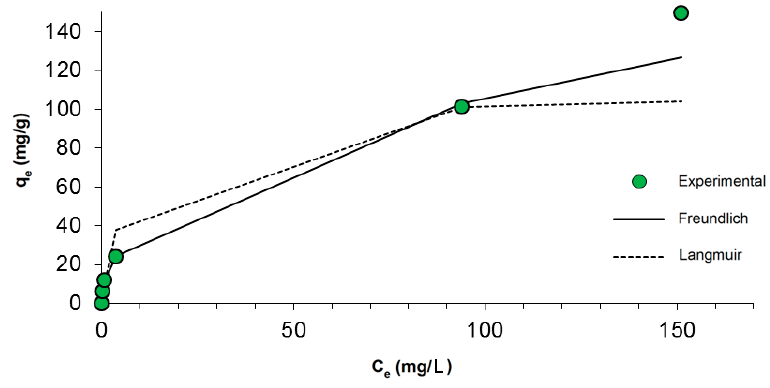
Figure 4. Fit of experimental data to the Langmuir and Freundlich models.